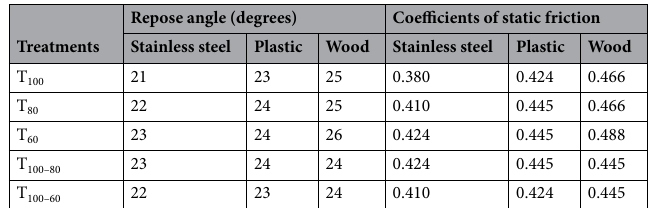
Table 3. Repose angle and coefficients of static friction of sunflower seeds at different surfaces and water treatments.